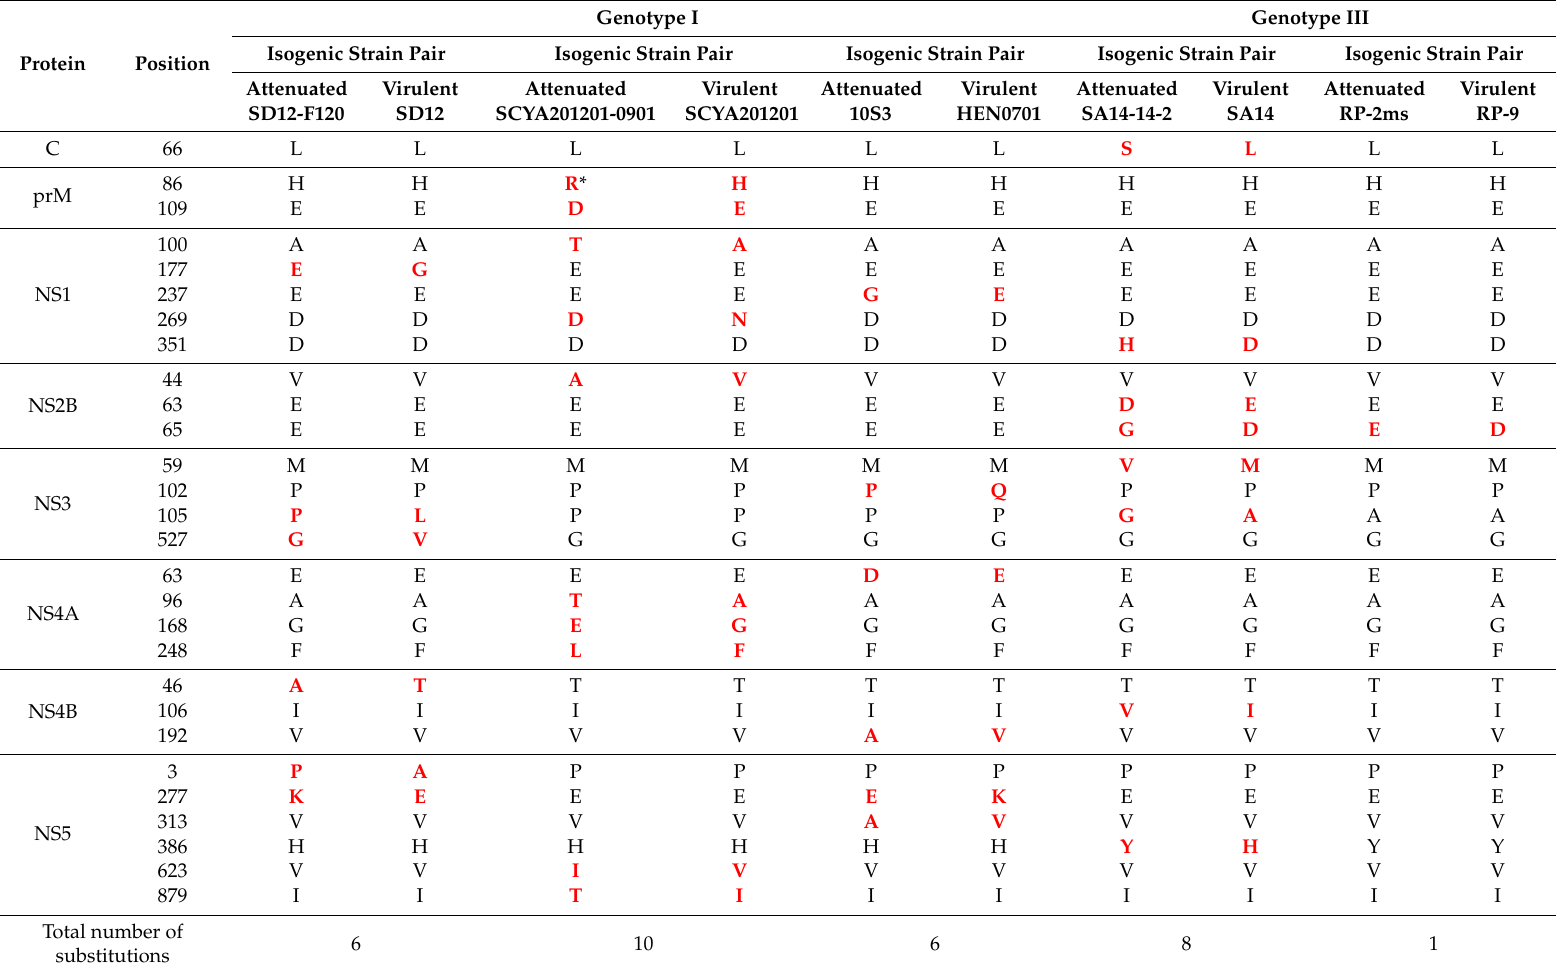
Table 3. Amino acid substitutions in other viral proteins between attenuated and virulent